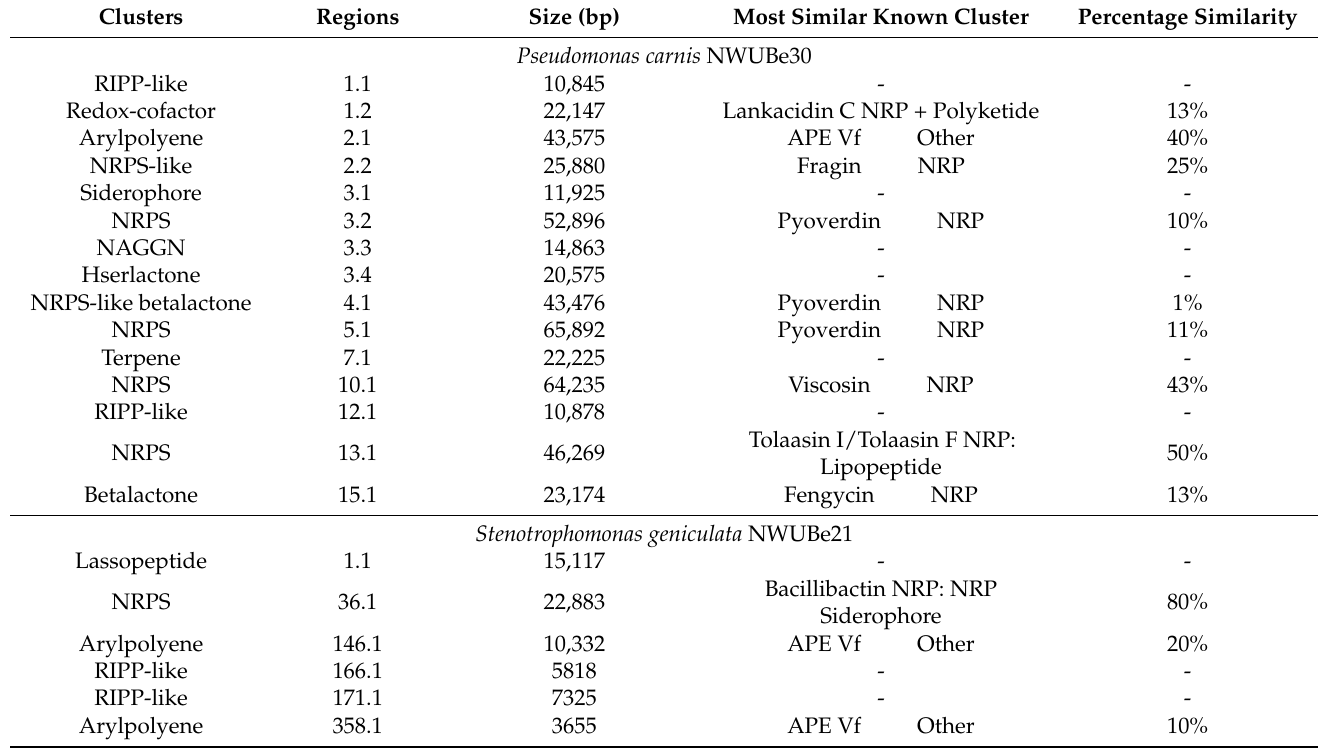
Table 3. Biosynthetic gene clusters of two endophytic bacterial strains, as predicted by antismash.